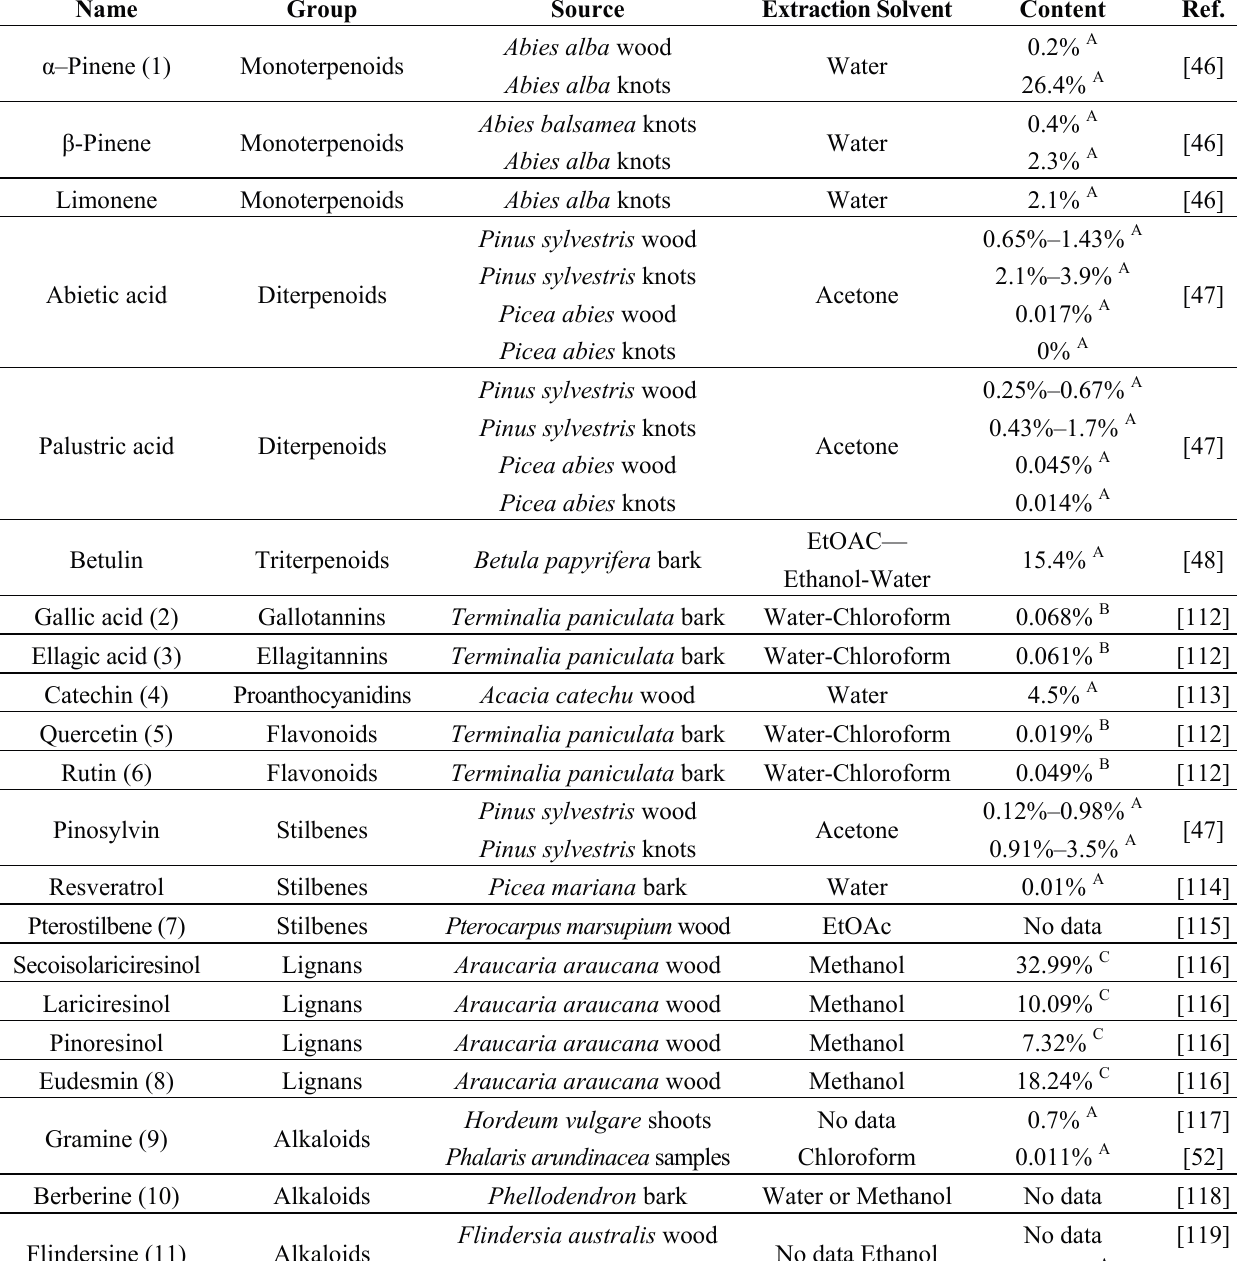
Table 4. Extraction of terpenoids, polyphenols and alkaloids from natural